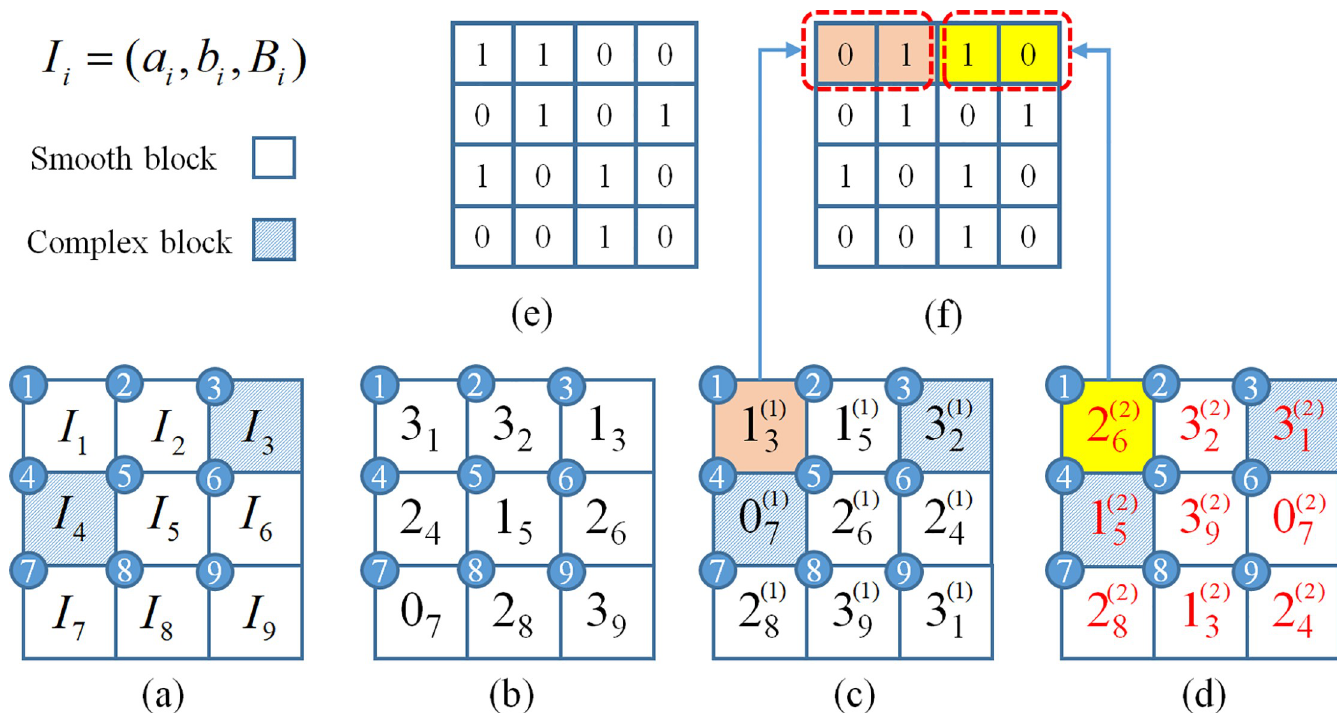
Fig 2. Illustration of the generation and embedment of recovery codes. (a) f I